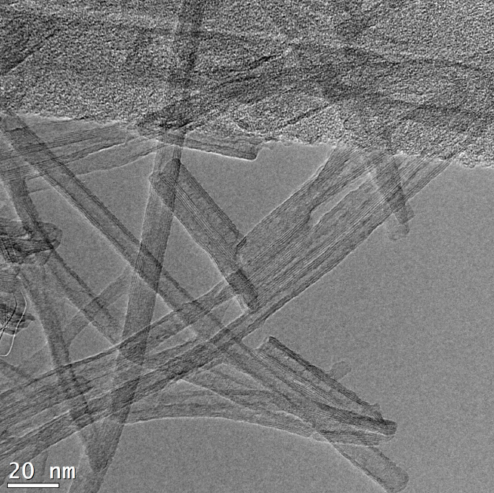
Figure 1. Transmission electron microscopy (TEM) micrograph of the as-prepared titanate